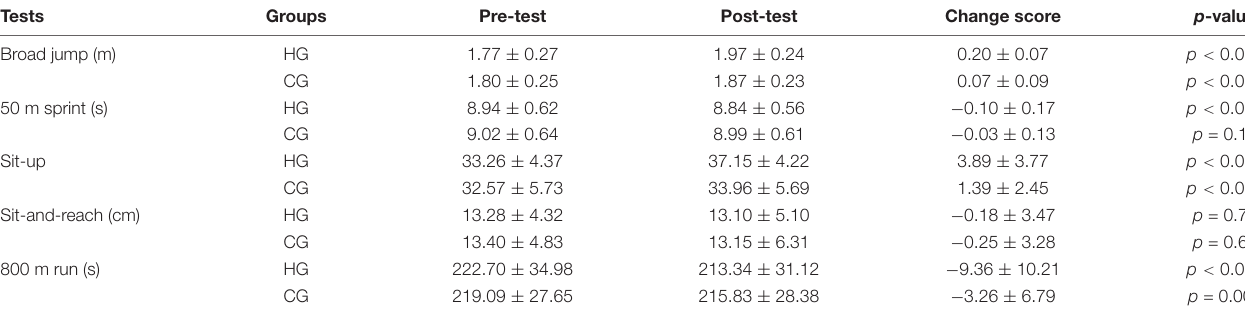
FIGURE 3 | Distribution of time participants began jump rope exercise. TABLE 2 | Statistics of one-way repeated measures ANOVA by individual